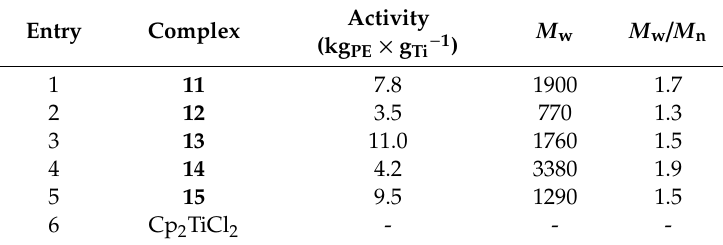
Table 4. Ethylene polymerization catalyzed by 11-15 / EASC systems [10,11].